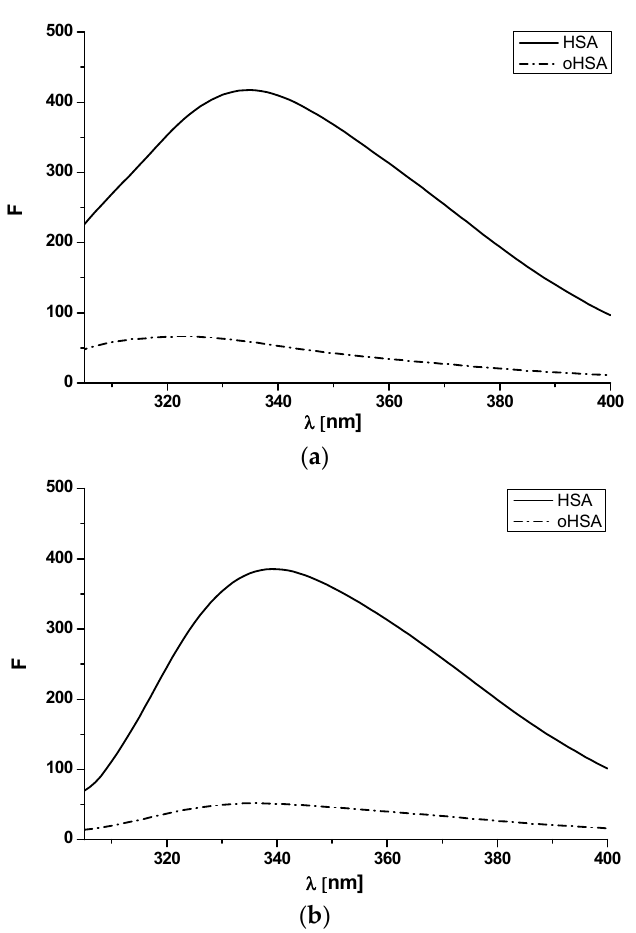
Figure 3. Emission fl uorescence spectra of unmodi fi ed (HSA) and oxidized (oHSA) human serum